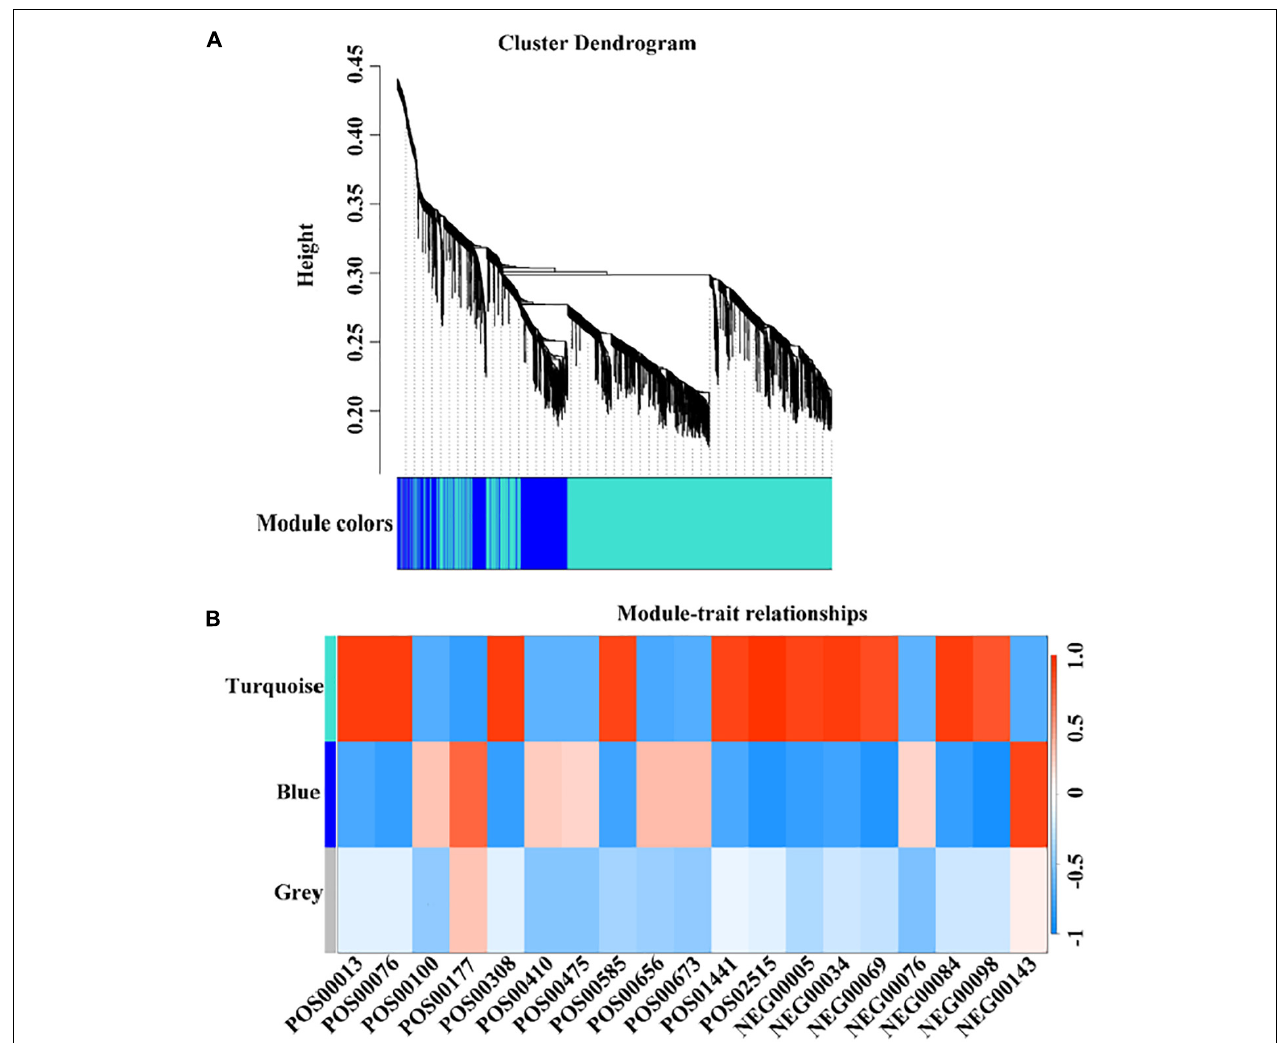
FIGURE 6 | Weighted Gene Co-expression Network Analysis (WGCNA) of co-expressed DEGs. (A) The colors of each block indicate the correlation coefficient between the modules and the traits. (B) The bar on the right represents the range of correlation coefficients between modulus and traits. The redder means the more positive correlation, and the bluer means the more negative